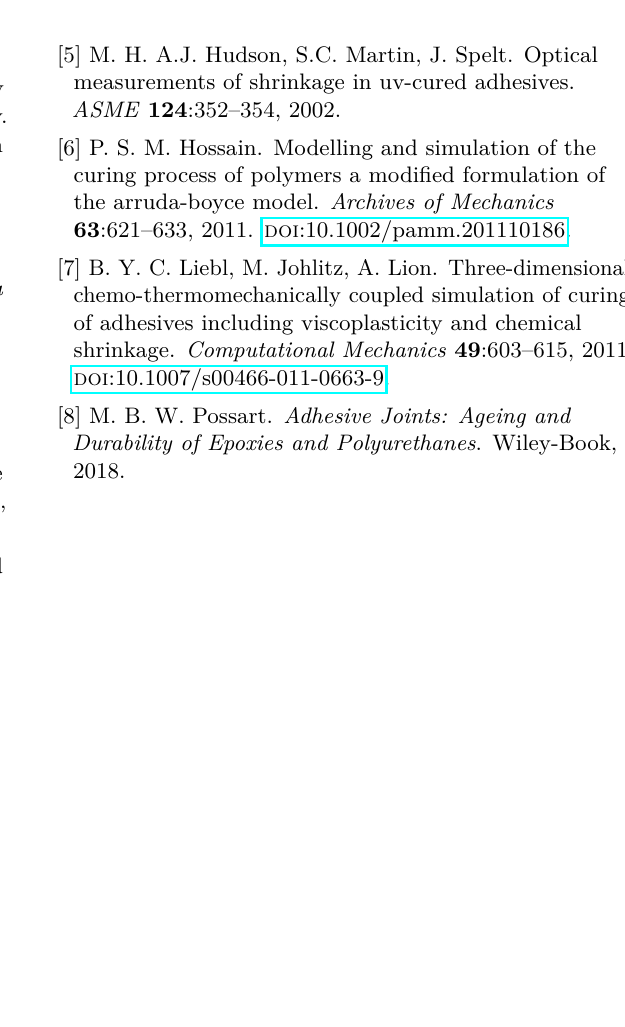
Figure 7. Final design of a MDA machine for rheometric analysis of